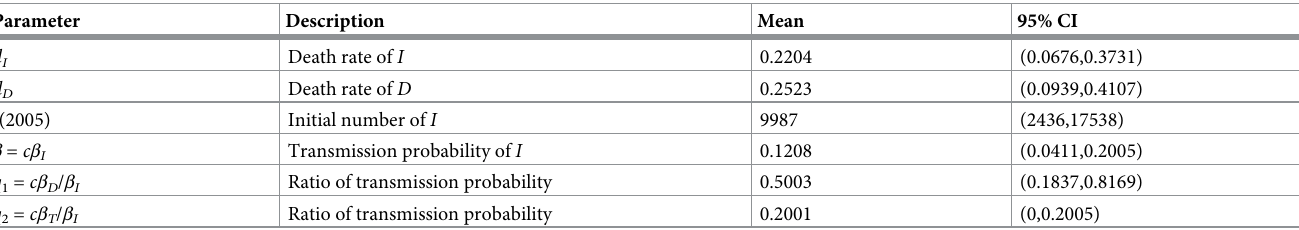
Table 7. Estimated parameters result of